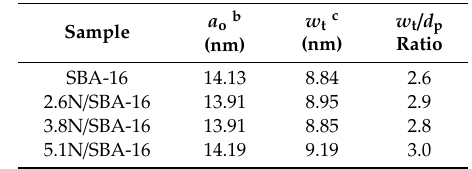
Table 2. Unit cell parameter ( a o ), and pore wall thickness ( w t ) of the bare SBA-16 and amine-functionalized adsorbents.